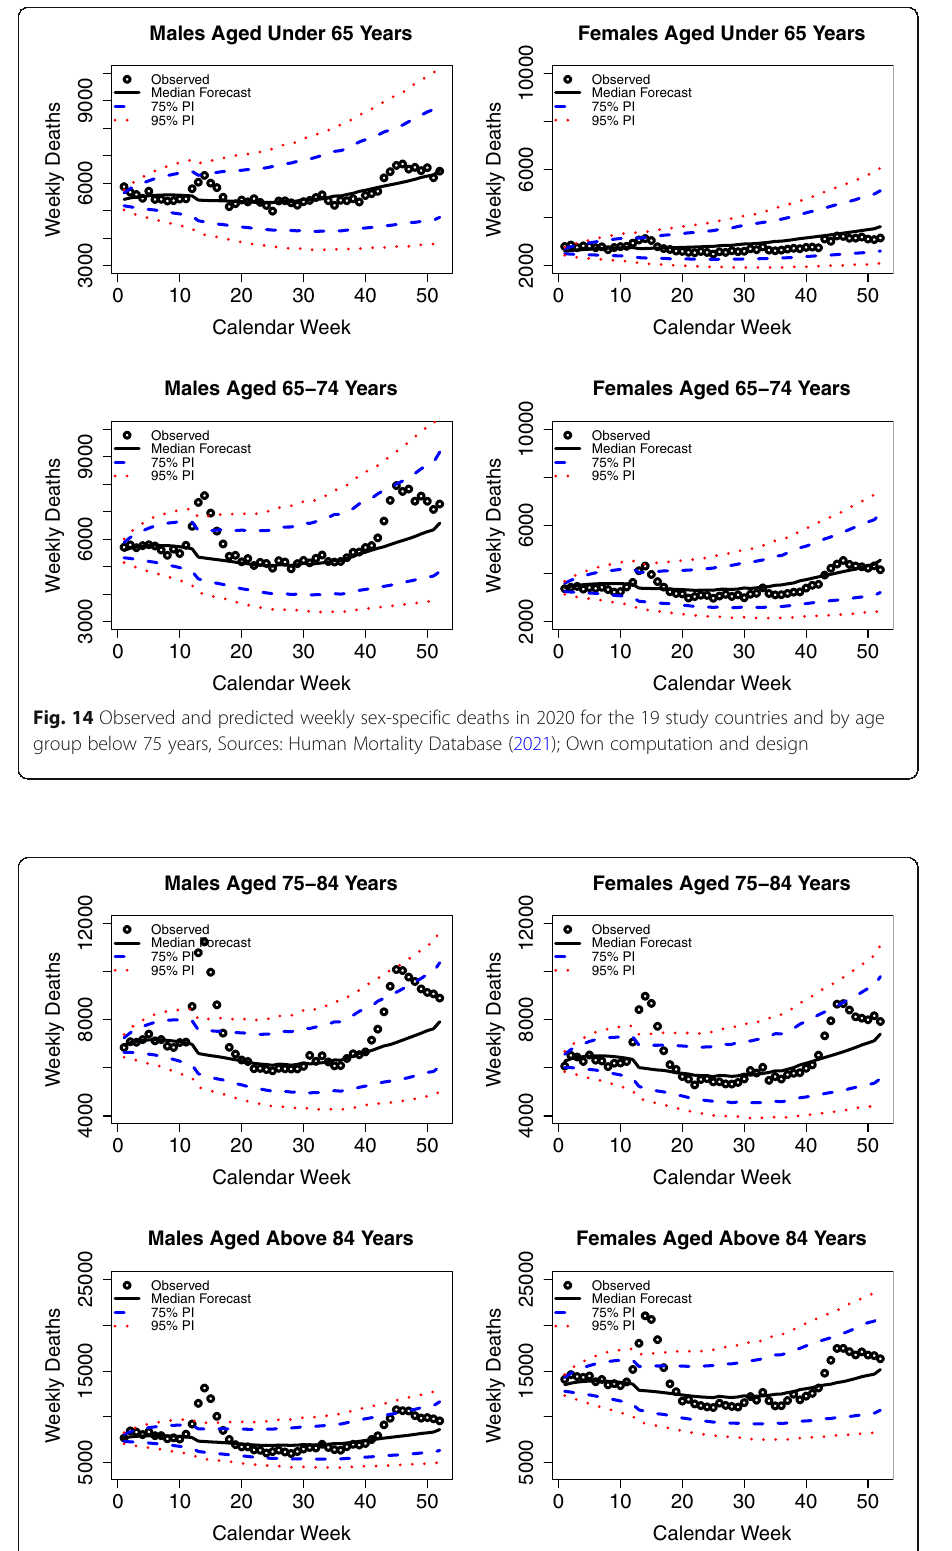
Fig. 15 Observed and predicted weekly sex-specific deaths in 2020 for the 19 study countries and by age group above 74 years. Sources: Human Mortality Database (2021); Own computation and